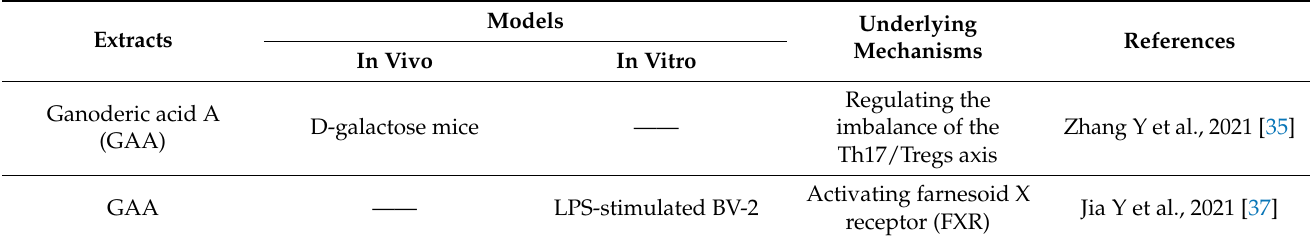
Table 3. The anti-neuroinflammatory effects of GL extracts on central nervous system